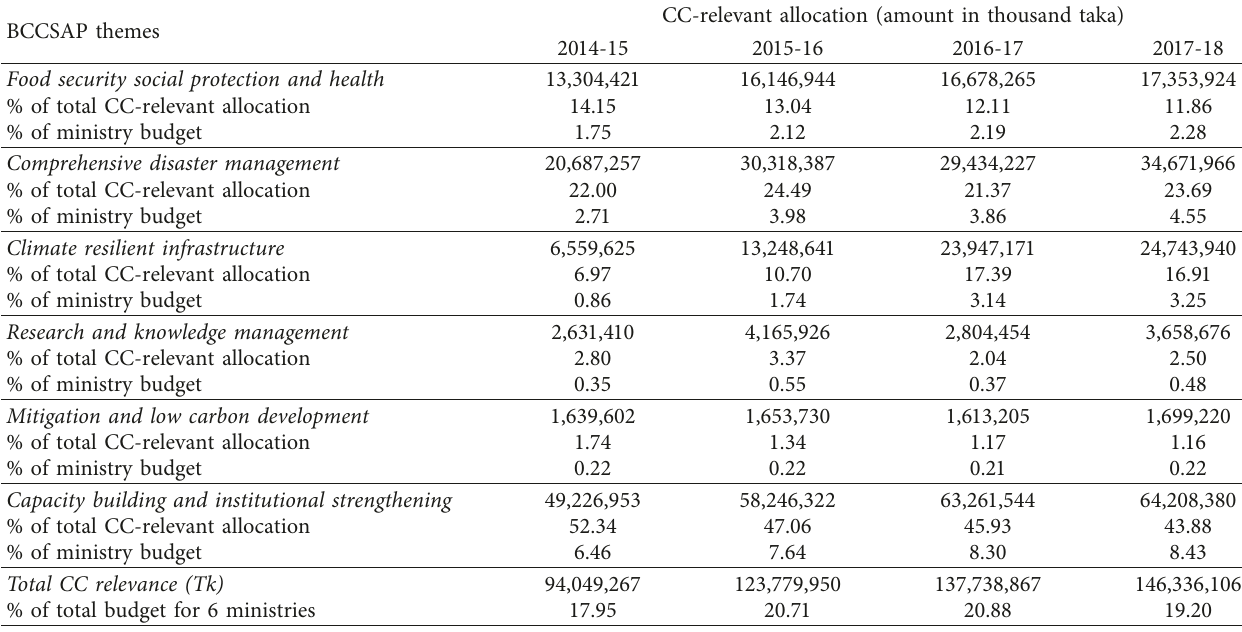
Table 2: Allocation in BCCSAP thematic areas in the selected ministry budget